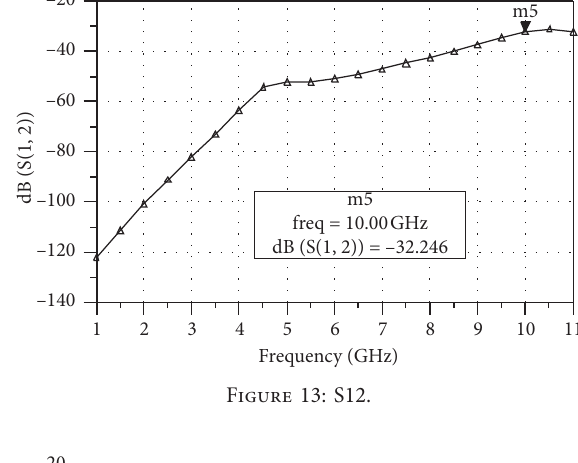
Figure 10: μ test.